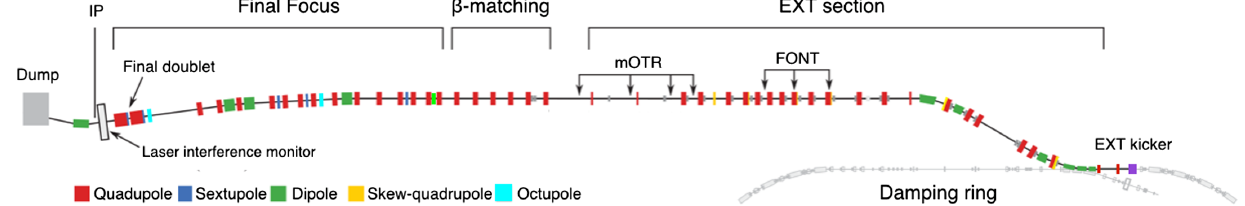
FIG. 1. Schematic diagram of the ATF2 beam line. mOTR: multi-optical transition radiation monitor; FONT: feedback on nanossecond timescale; EXT: extraction.